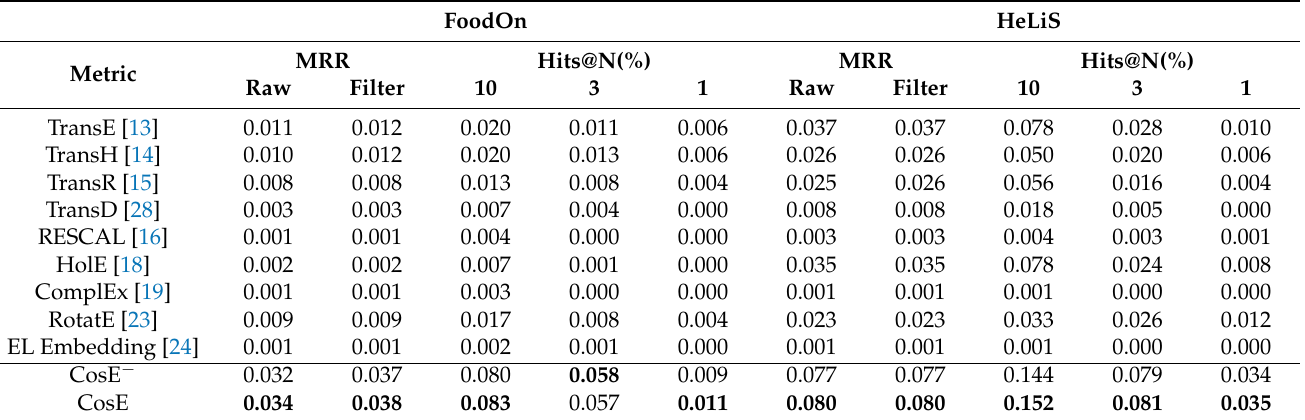
Table 3. The results of FootOn and HeLiS on link